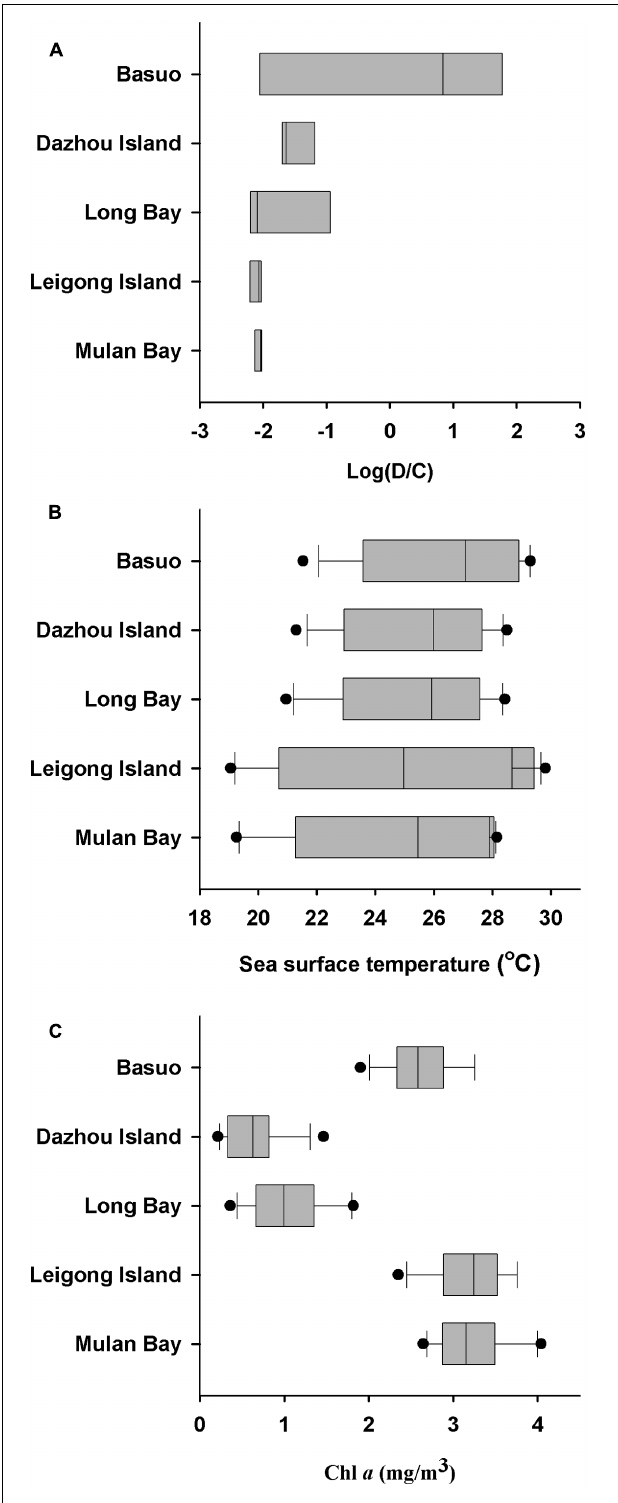
FIGURE 5 | Changes in dominant Symbiodinium clades, sea surface temperature (SST), and chlorophyll a (Chl a ) concentrations. (A) Log ratio of Symbiodinium clade D/C relative abundance at each location. (B) Variation of